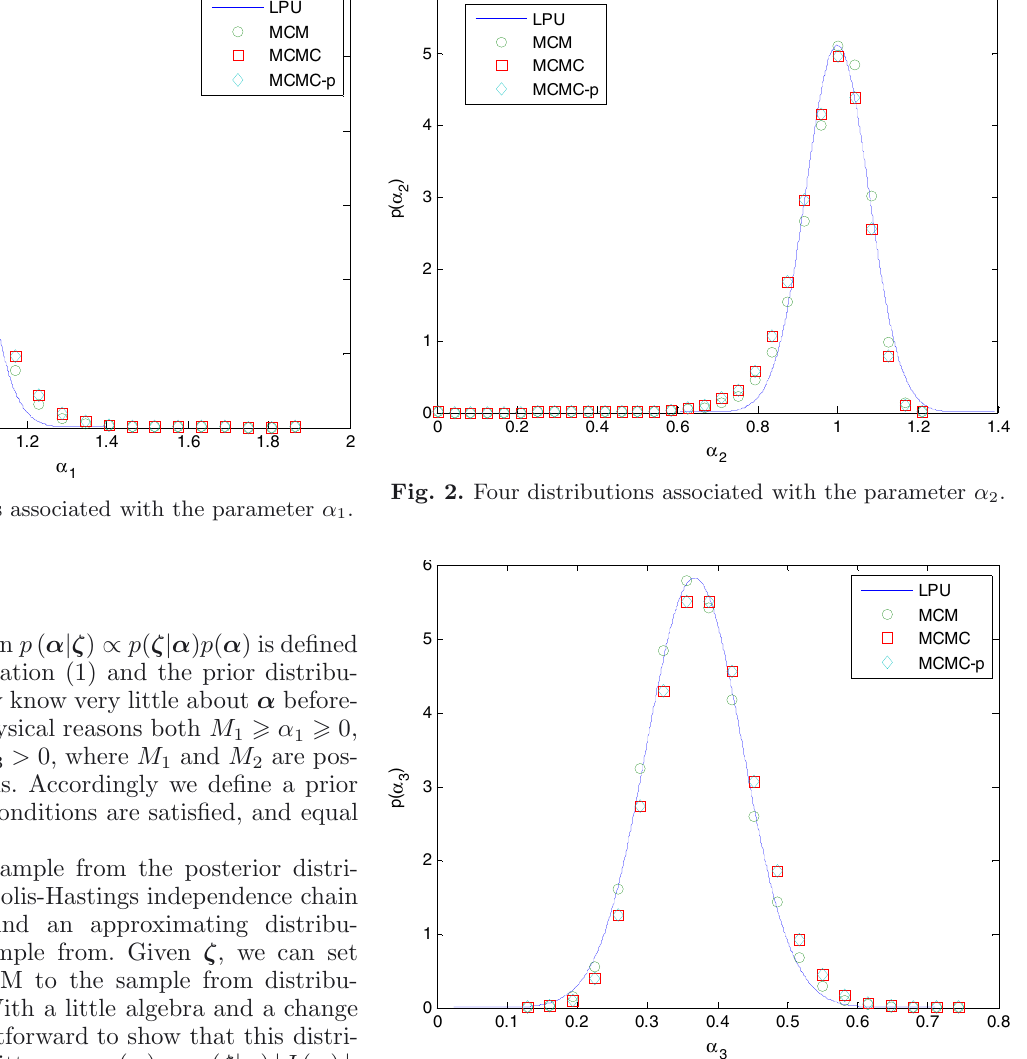
Fig. 3. Four distributions associated with the parameter α 3